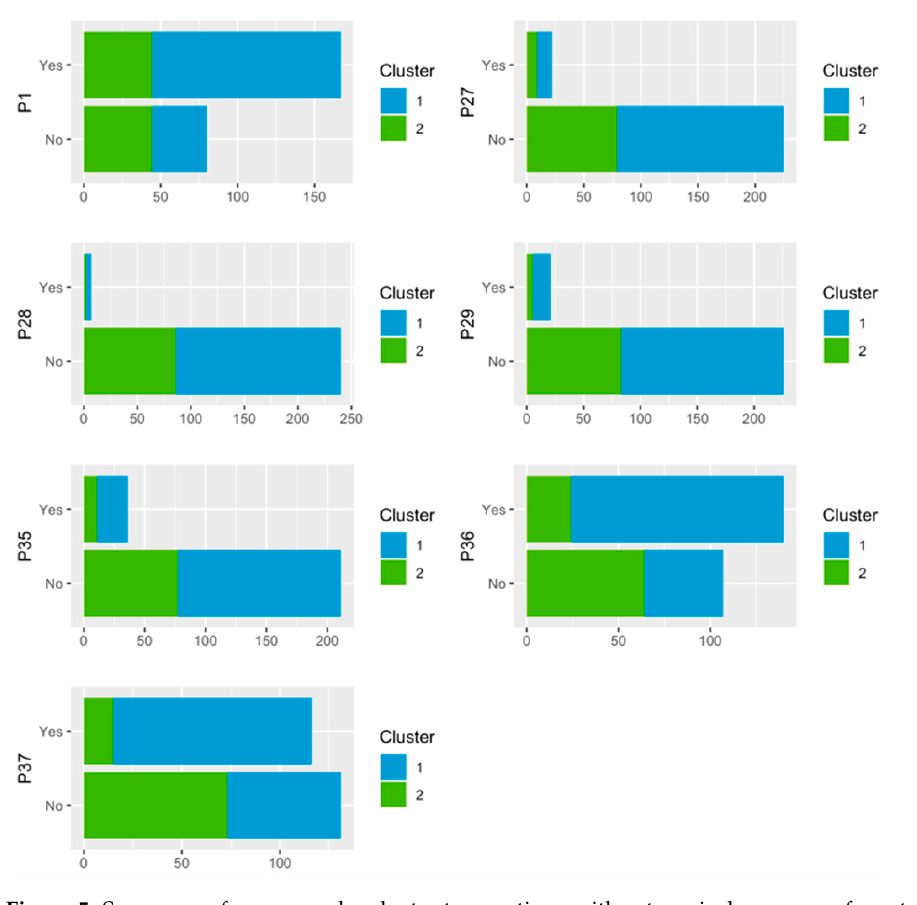
Figure 6. Summary of responses by cluster to questions with categorical responses from multiple categories. Source: compiled by the authors. The main fi nding of this research is presented in Figure 7, which shows how people who live in large cities value the di ff erent land use impact of tourism in their local com- munities more negatively than those that live in smaller towns. These results are more prominent for certain aspects, such as economic impact.